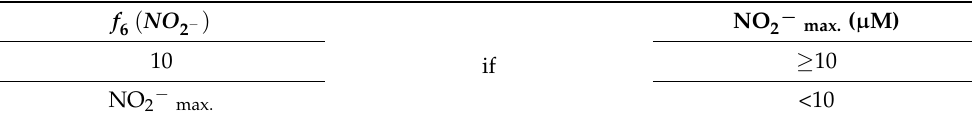
Table 6. The ranges used to assign values for